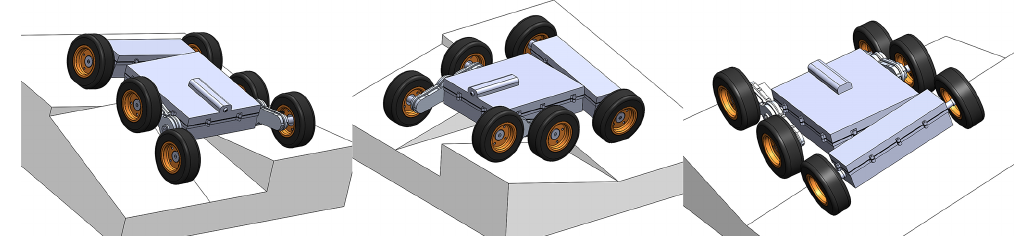
Figure 4. The robot can adapt to different terrain and maintain all the wheels in contact with the ground, relying on its three-rocker-arm